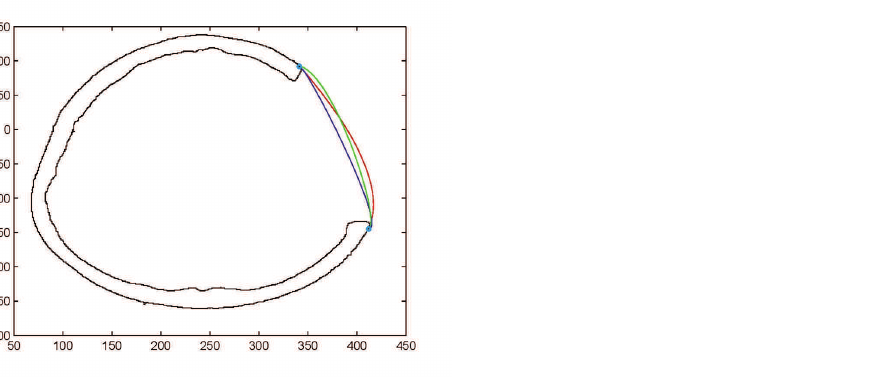
Figure 15. Comparison of C 1 , GC 1 rational Ball curves (purple and green curves are constructed using C 1 and red curve is constructed using GC 1 ) .